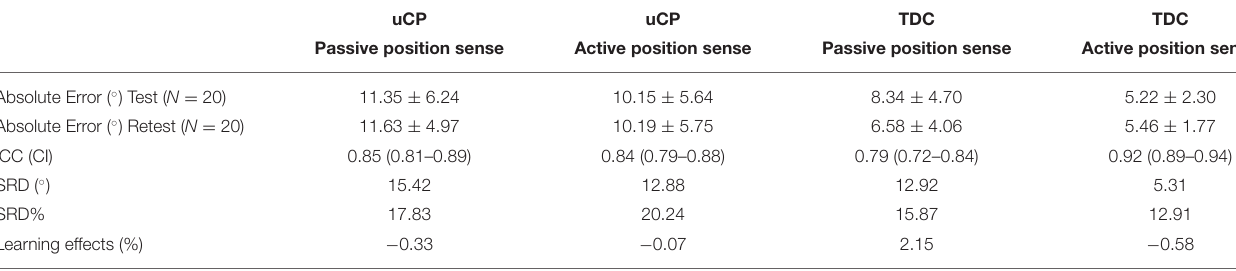
TABLE 1 | Results of test-retest reliability in uCP and TDC for passive and active position sense assessments.